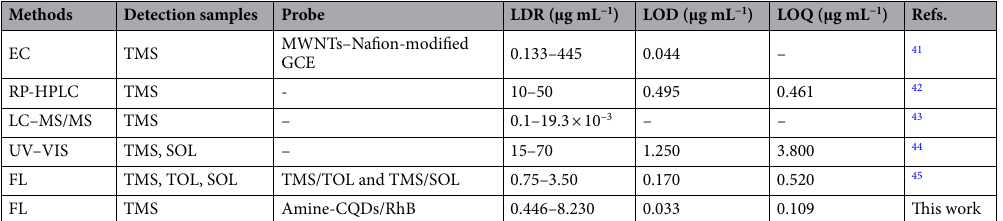
Table 1. The comparison of the present study with other reported approaches for TMS detection.